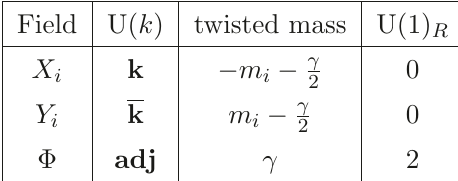
Figure 2 . The A M linear quiver that corresponds to figure 1 with the ranks of the flavour groups L i = 0, i = 1 , . . . , M − 1, L M = L , and the ranks of the gauge groups k 1 ≤ k 2 ≤ . . . ≤ k M ≤ L .